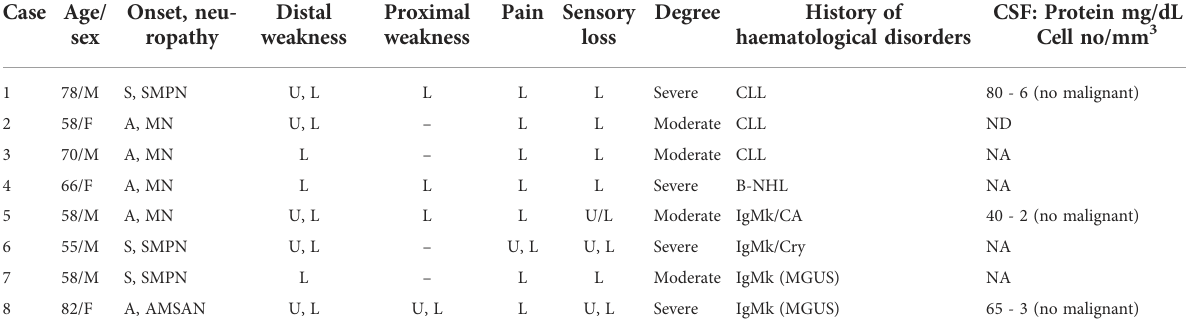
TABLE 1 Clinical characteristic of patients with